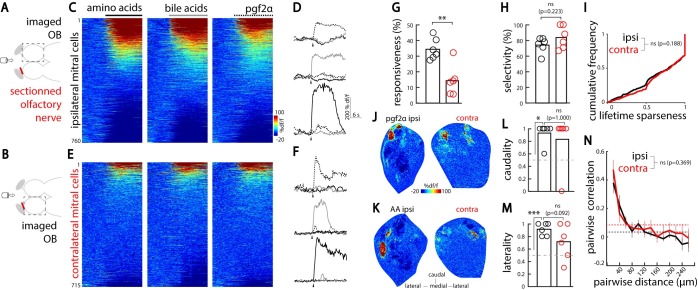
Natural odors elicit odor-selective and chemotopically organized responses in the contralateral OB.(A) Illustration of the experimental setup depicting an adult zebrafish brain explant expressing GCaMP6s in mitral cells. A tube delivers the olfactory cues to the nostrils. The stimuli used are AAs, bile acids, and pgf2α. The olfactory nerve is sectioned (red mark) on the contralateral OB. Mitral cell odor responses are recorded in the OB with an intact olfactory nerve using two-photon calcium imaging. (B) Illustration of the experimental setup depicting an adult zebrafish brain explant. Mitral cell odor responses are recorded in the deafferented OB using two-photon calcium imaging. (C) Odor response time course of all ipsilateral mitral cells pooled and sorted by their response amplitude (760 cells in six fish). (D) Odor response time course of three representative odor-selective ipsilateral mitral cells. Arrowheads indicate odor onset. (E) Odor response time course of all contralateral mitral cells pooled and sorted by decreasing responsiveness (715 cells in six fish). (F) Odor response time course of three representative odor-selective contralateral mitral cells. Arrowheads indicate odor onset. (G) The percentage of mitral cells responding to at least one olfactory cue is larger in the ipsilateral OB (black) than in the deafferented contralateral OB (red) (**p < 0.01; Student t test). (H) The percentage of mitral cells responding to only one of the presented odors was similar in the ipsilateral (black) and contralateral OB (red) (Student t test). (I) The cumulative frequency of lifetime sparseness for all mitral cells was similar in both OBs. ns; two-sample, two-tailed Kolmogorov–Smirnov test. (J) Ipsilateral (left) and contralateral (right) OB responses to pgf2α in the same fish (representative planes located 50 μm deep from the ventral OB surface). (K) Ipsilateral (left) and contralateral (right) OB responses to AA mix in the same animal than in (J) (representative planes located 90 μm deep from the ventral OB surface). (L) Spatial distribution of mitral cells responding selectively to pgf2α, along the rostrocaudal axis in both OBs for all fish. Values close to 1 indicate caudal locations, whereas values close to 0 indicate rostral locations. Note the caudal location of pgf2α-selective ipsilateral cells compared with the random distribution indicated by the gray dashed line (*p < 0.05; Mann–Whitney U test). The caudality index of contralateral pgf2α-selective cells is similar to that of ipsilateral pgf2α-selective cells (ipsi- versus contralateral, ns; Mann–Whitney U test). (M) Location of mitral cells responding selectively to AAs along the mediolateral axis in both OBs for all fish. Values close to 1 indicate lateral locations, whereas values close to 0 indicate medial locations. Note the lateral location of ipsilateral AA-selective cells compared with the random distribution indicated by the gray dashed line (***p < 0.001; one-sample Student t test). The laterality index of contralateral AA-selective cells is similar to that of ipsilateral AA-selective cells (ipsi- versus contralateral, ns; Student t test). (N) The pairwise similarity in mitral cell responses as a function of the distance between them (ipsilateral, n = 6 fish; contralateral, n = 6 fish; ns; Student t test). Dashed lines indicate the average correlation after shuffling the spatial locations of mitral cells. Numerical data used to generate this figure can be found in S1 Data and S2 Data. AA, amino acids; contra, contralateral; GCaMP6, genetically encoded calcium sensor, circular permutated green florescent protein-Calmodulin-M13 peptide 6; ipsi, ipsilateral; ns, nonsignificant; OB, olfactory bulb; pgf2α, prostaglandin 2α.